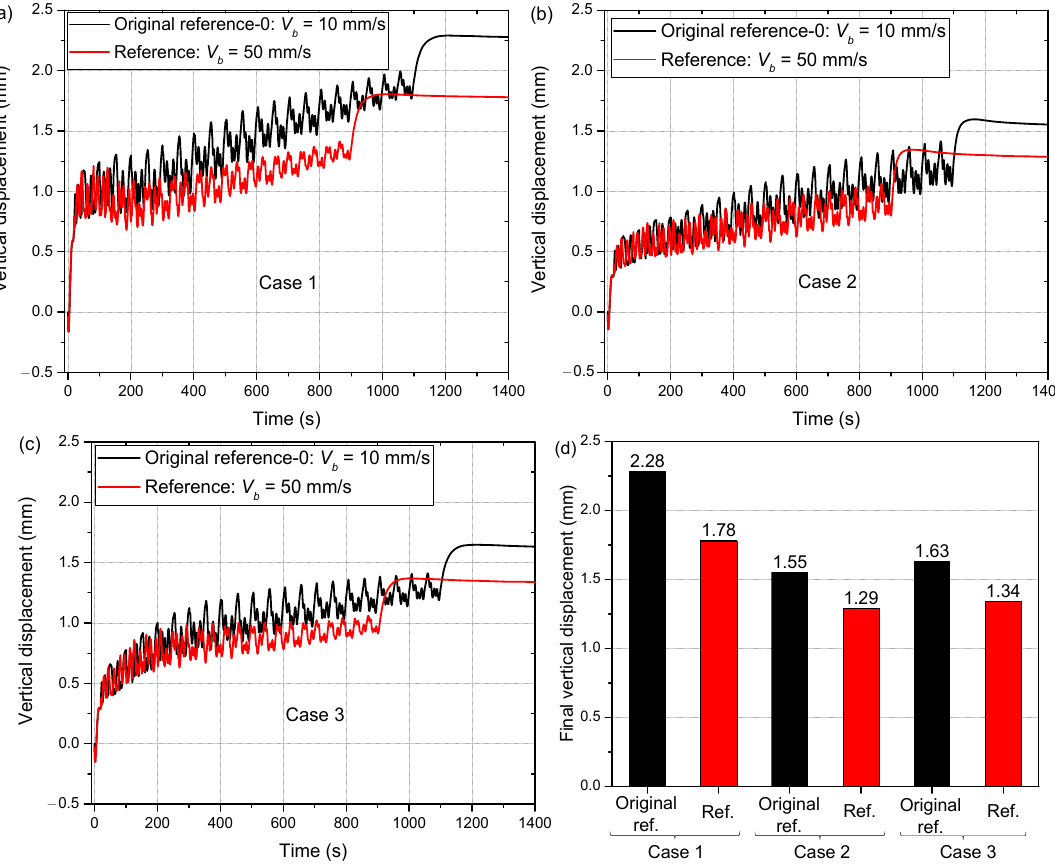
Figure 9. Evolutions of the vertical displacement of point DS1 (see Figure 2): ( a ) Case 1; ( b ) Case 2; ( c ) Case 3; ( d ) final displacement under three cases.